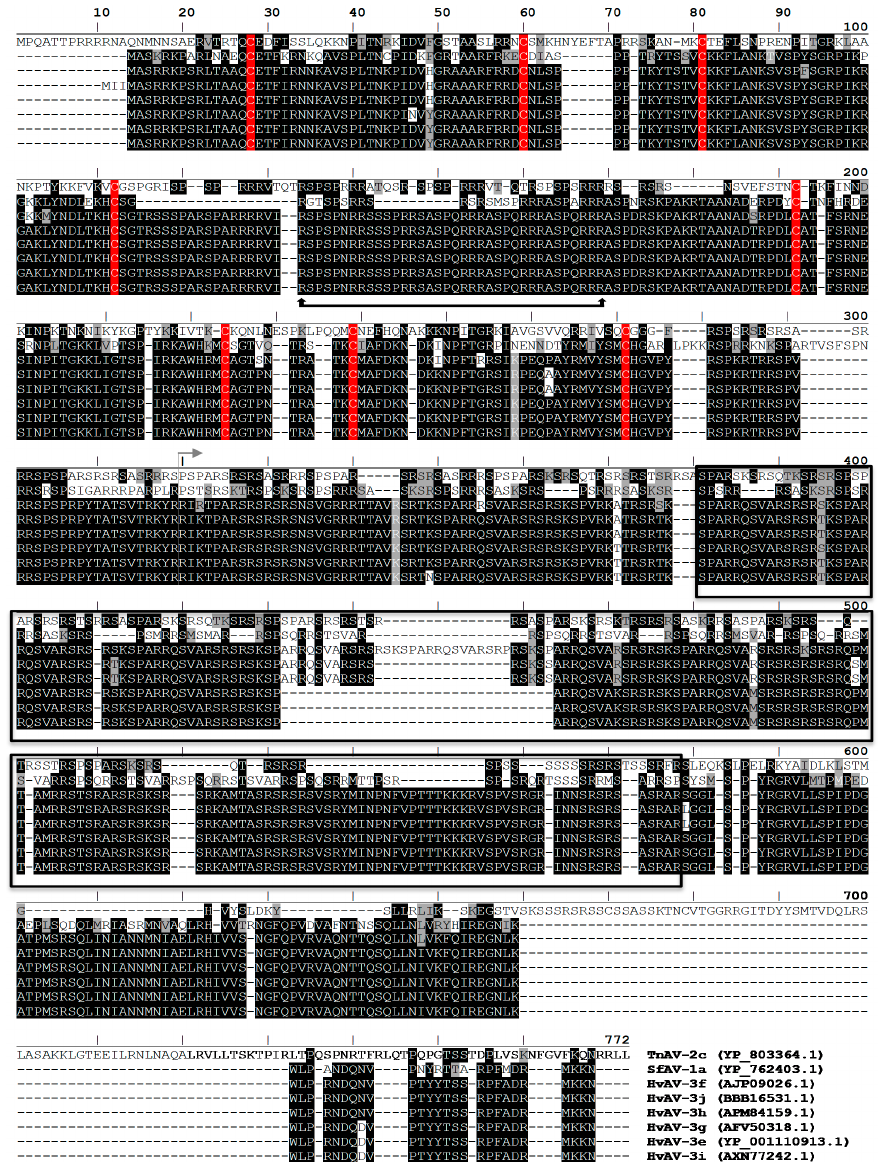
Figure 4. Alignment of ascovirus (AV) P64 homologs encoded by Trichoplusia ni AV-2c (TnAV-2c), Spodoptera frugiperda AV-1a (SfAV-1a), and various isolates of Heliothis virescens AV (HvAV-3e, -3f, -3g, -3h, -3i, -3j). GenBank accession numbers in parentheses, conserved cysteines (highlighted red) in the virus-specific 2-cysteine adaptor (vs2C-ad) motif and intervening stretch of basic residues (bold underline with vertical arrows) in the N-terminal domain, and arginine/serine rich repeats in the C-terminal domain (boxed, black line) are shown; the N-terminal and C-terminal domains are delineated (grey horizontal arrow) based on the SfAV-1a’s P64 protein (Tan et al., 2009